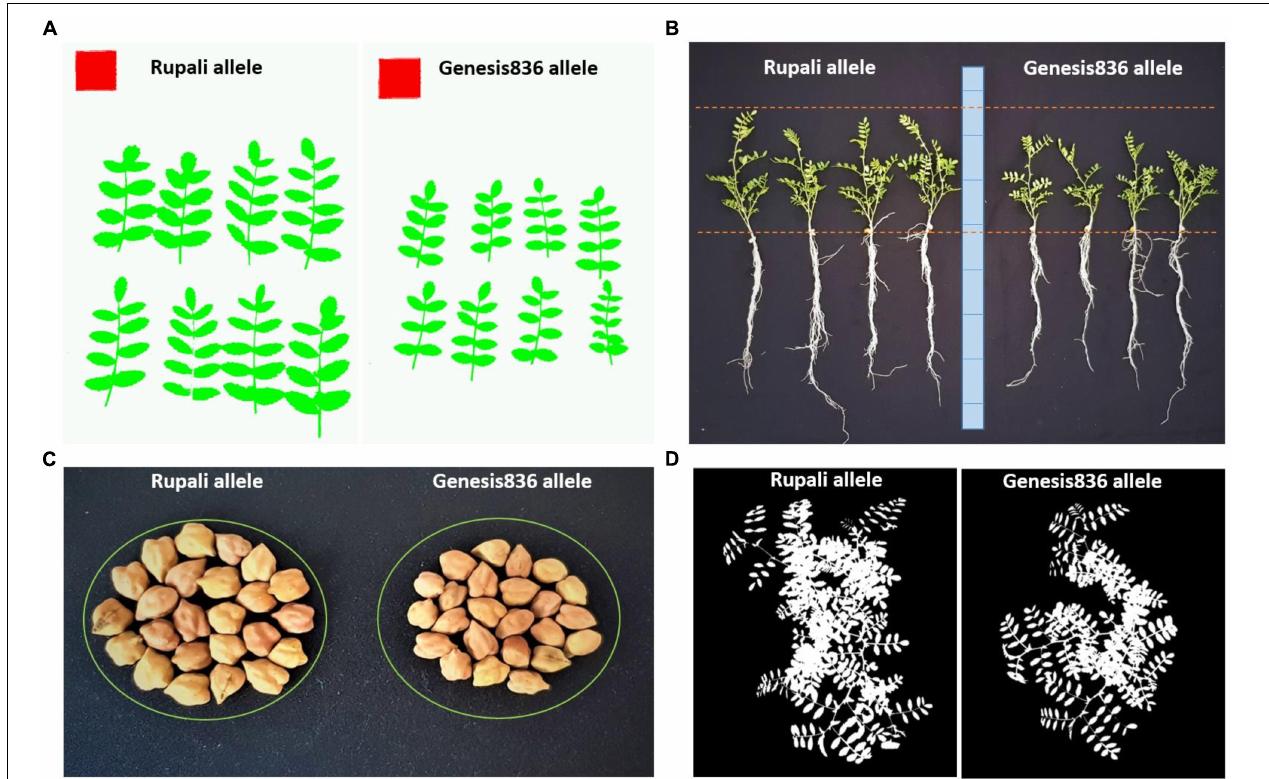
FIGURE 2 | Representative images showing differences in panel (A) leaf size, (B) biomass, (C) seed size, and (D) canopy size for plants carrying the Rupali or Genesis836 Ca4_Vqtl allele (NIL_50.7.81). Leaf images were taken using the Easy Leaf Area app (Easlon and Bloom, 2014), and canopy images were taken using the Canopeo application (Oklahoma State University, Stillwater, OK, United States;